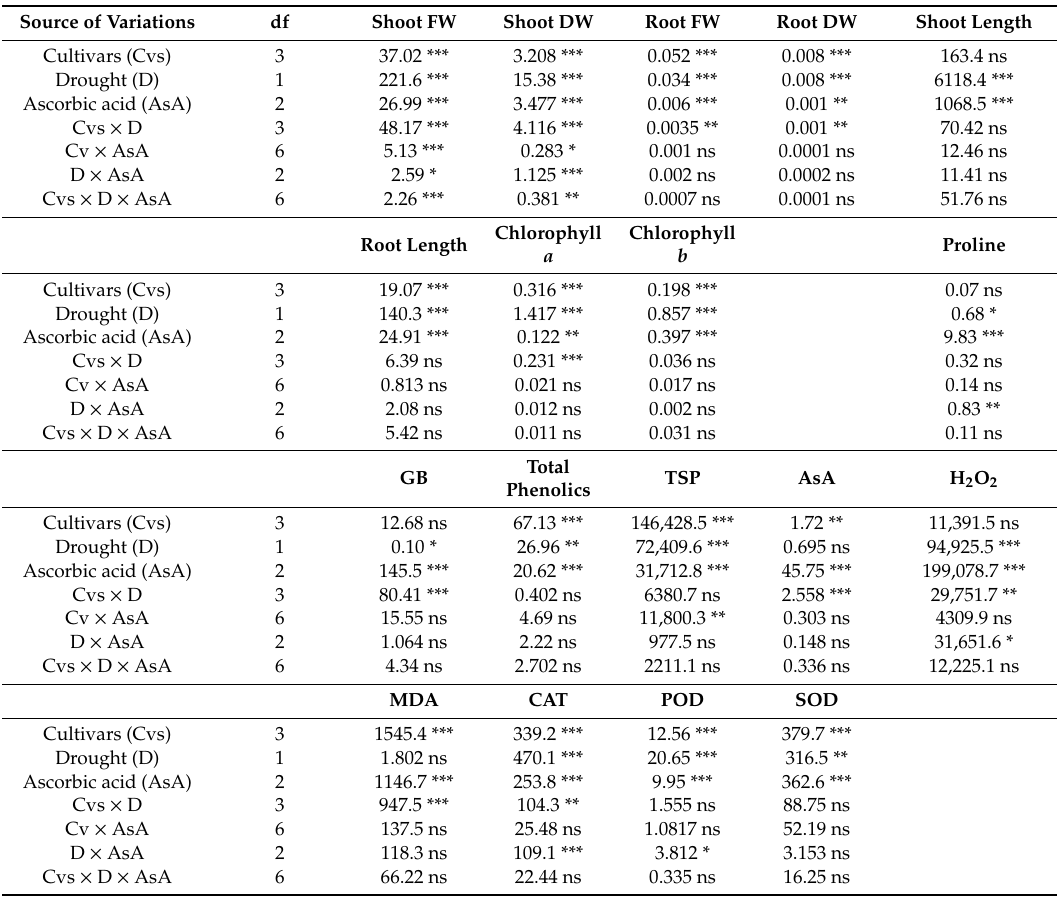
Table 1. Mean squares from three-way analysis of variance of data for di ff erent morphological and biochemical parameters of sa ffl ower ( Carthamus tinctorious L.) plants treated with foliar spray of ascorbic acid (AsA) under well-watered (control, 100% FC) and water deficit (60% FC) conditions. Source of Variations df